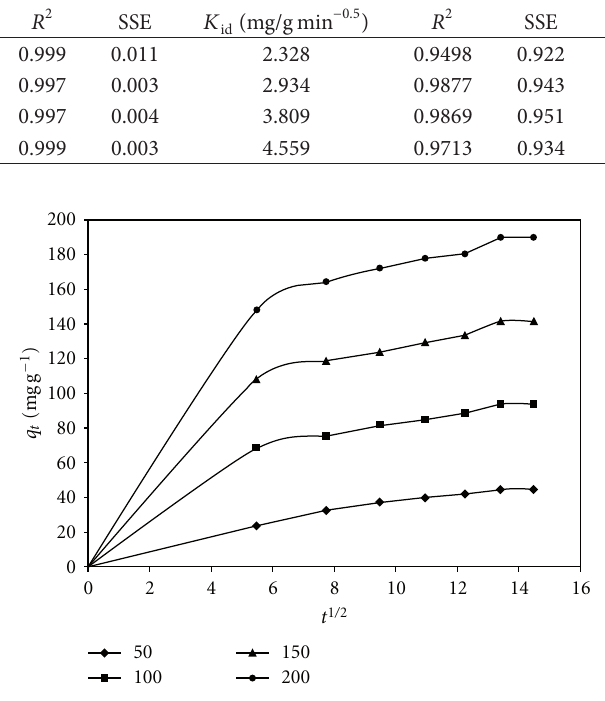
F 5: Weber and Morris plots for the biosorption of Ni(II) T. viride biomass